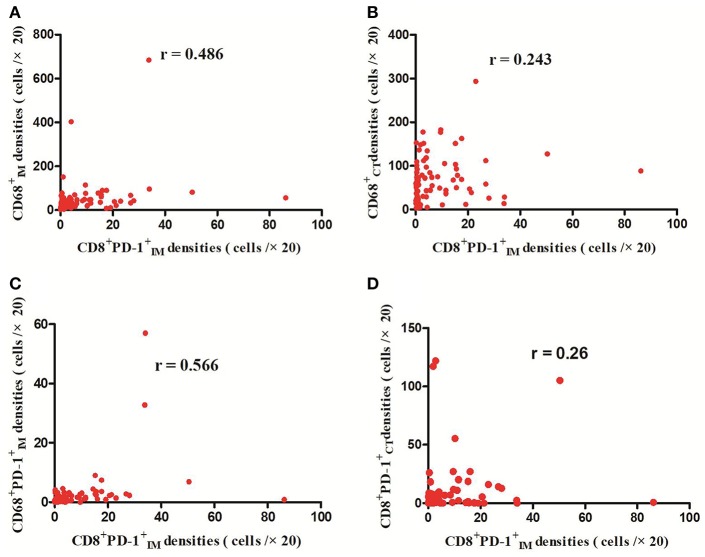
Positive correlations between CD8+PD-1IM+ and CD68IM+, CD68CT+, CD68+PD-1IM+, and CD8+PD-1CT+ cell densities (p < 0.01) (A–D).